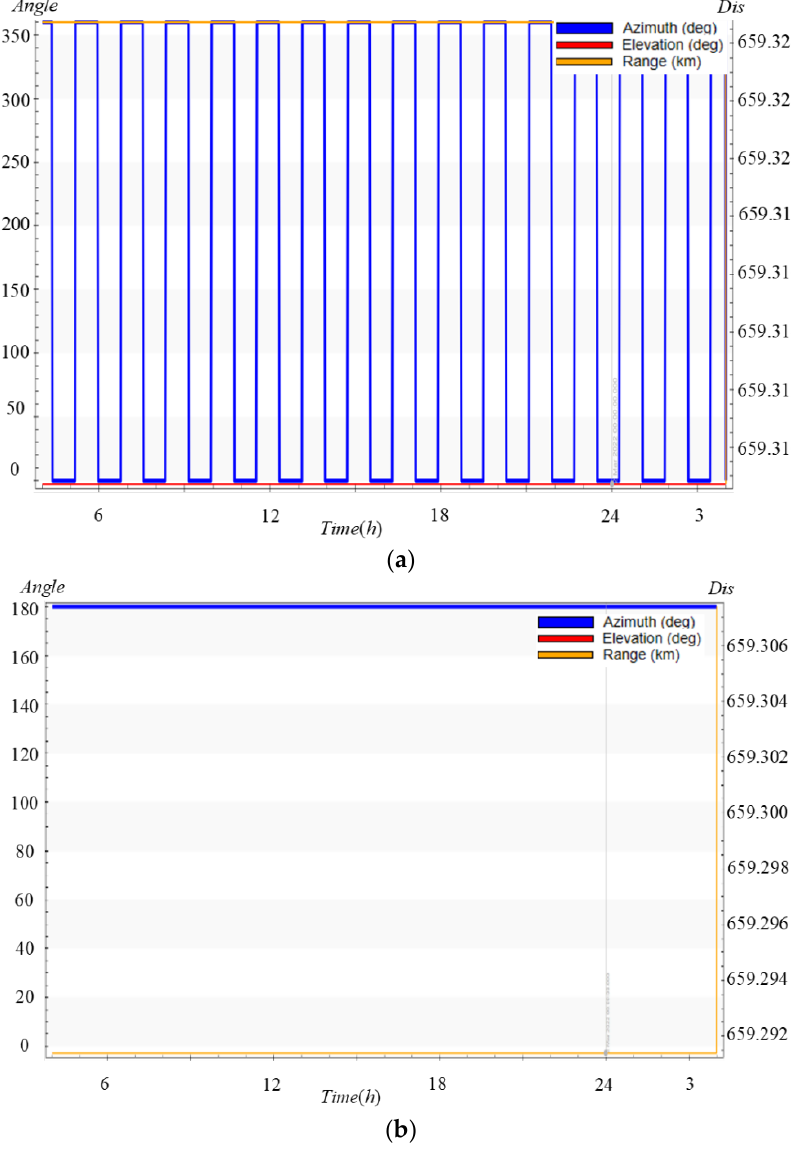
Figure 13. This is the schematic diagram of co-orbit link AER characteristic analysis. ( a ) Co-orbit forward link; ( b ) Co-orbit backward link.